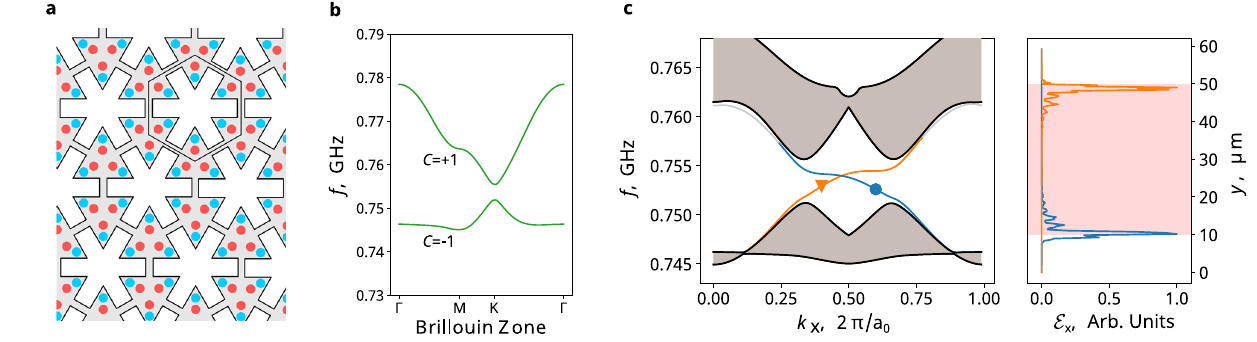
Fig. 4 | Phononic Chern insulators in a net-charge-neutral PZM structure. a Schematic drawing of a PZM phononic crystal with both positive (red) and negative charges (blue), giving rise to a net zero charge per unit cell. b Band